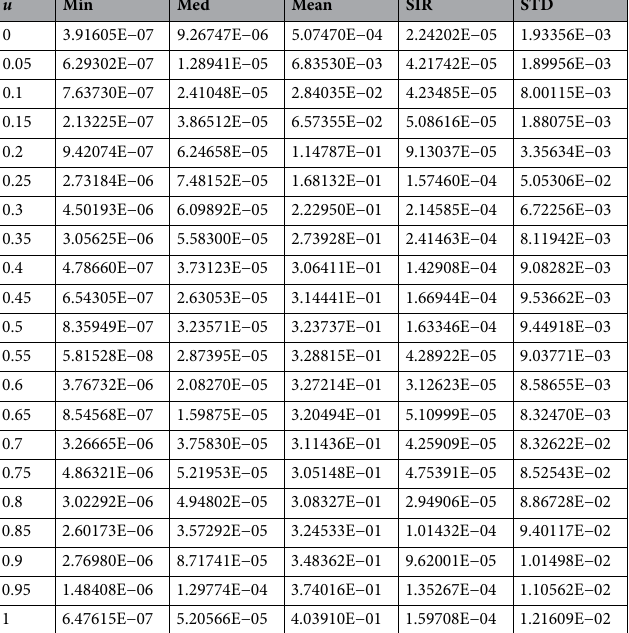
Table 2. Statistical presentations via stochastic performances for solving the novel SO-PSDDM-based Problem